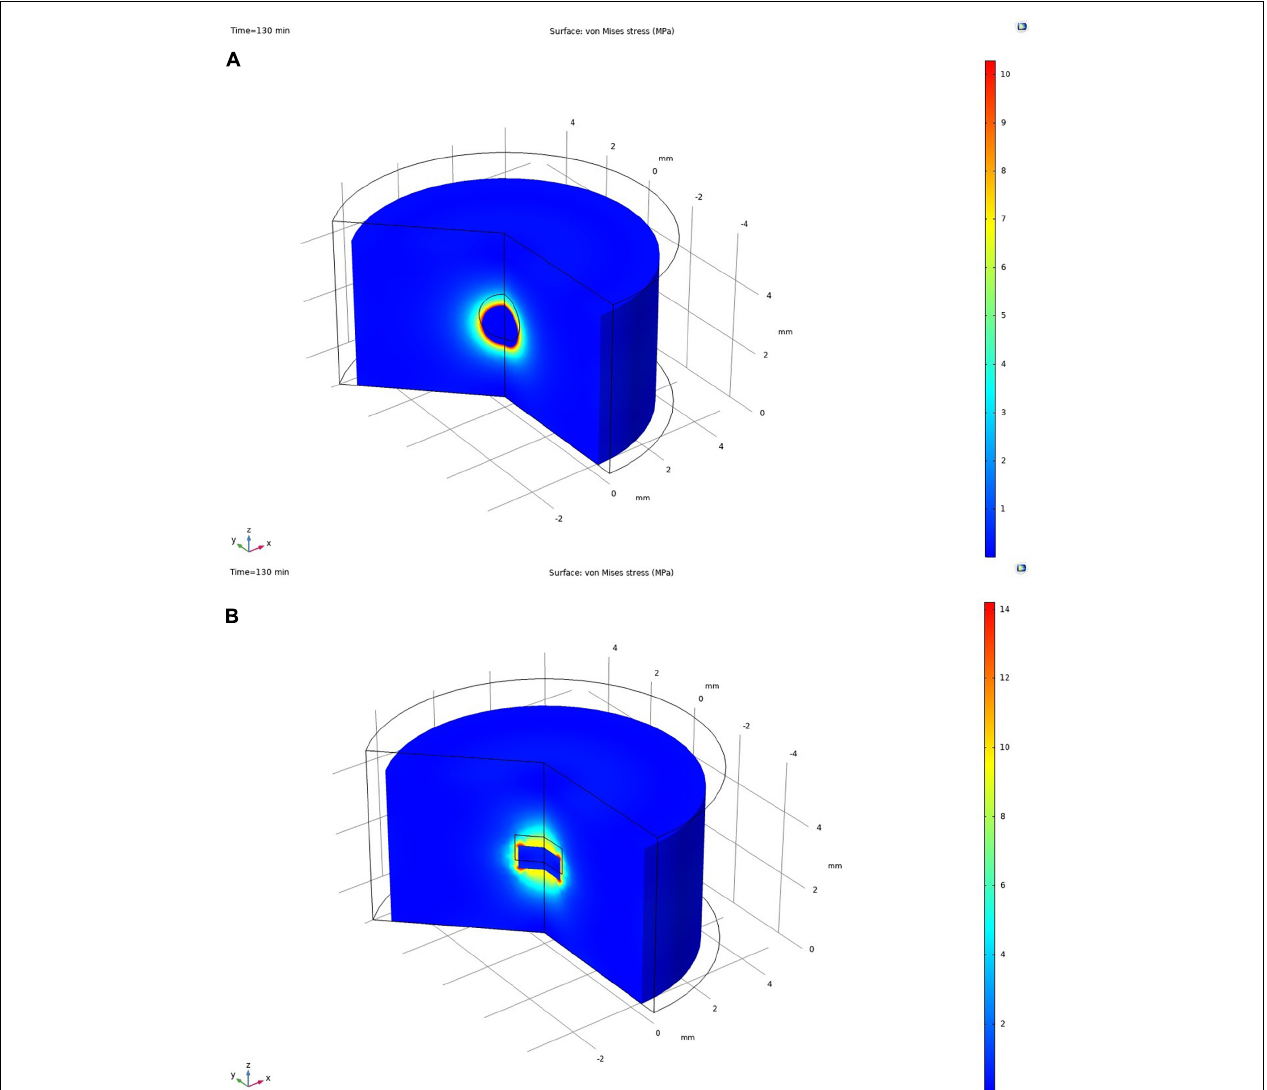
FIGURE 5 | Stress distributions in YSZ oxide pellets containing lumped Gd 2 O 3 (A) sphere ( r = 0.75 mm) or (B) mini-pellet ( r = h = 0.83 mm). (r is the radius of the sphere or mini-pellet and h is the height of the